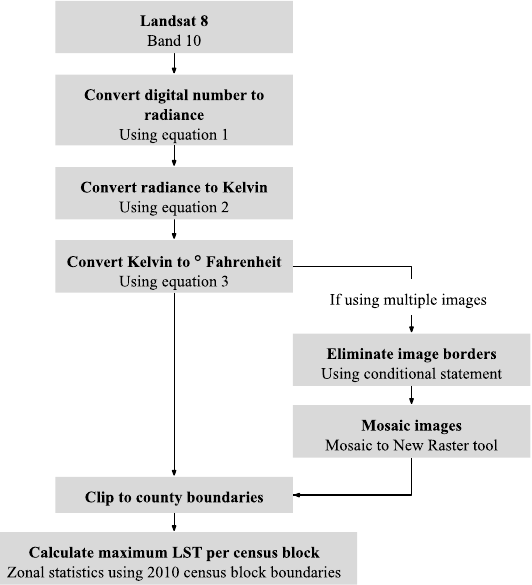
Figure 2. Processing steps for LST